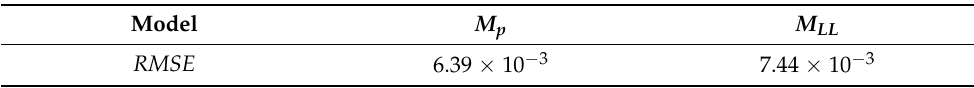
Table 1. RMSE of models in census